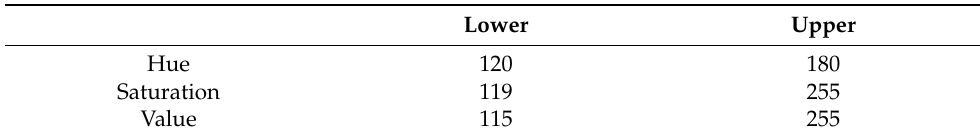
Table 1. Upper and lower HSV values used for plume identification by color were identified from a typical plasma plume image. Lower Upper Hue 120 180 Saturation 119 255 Value 115